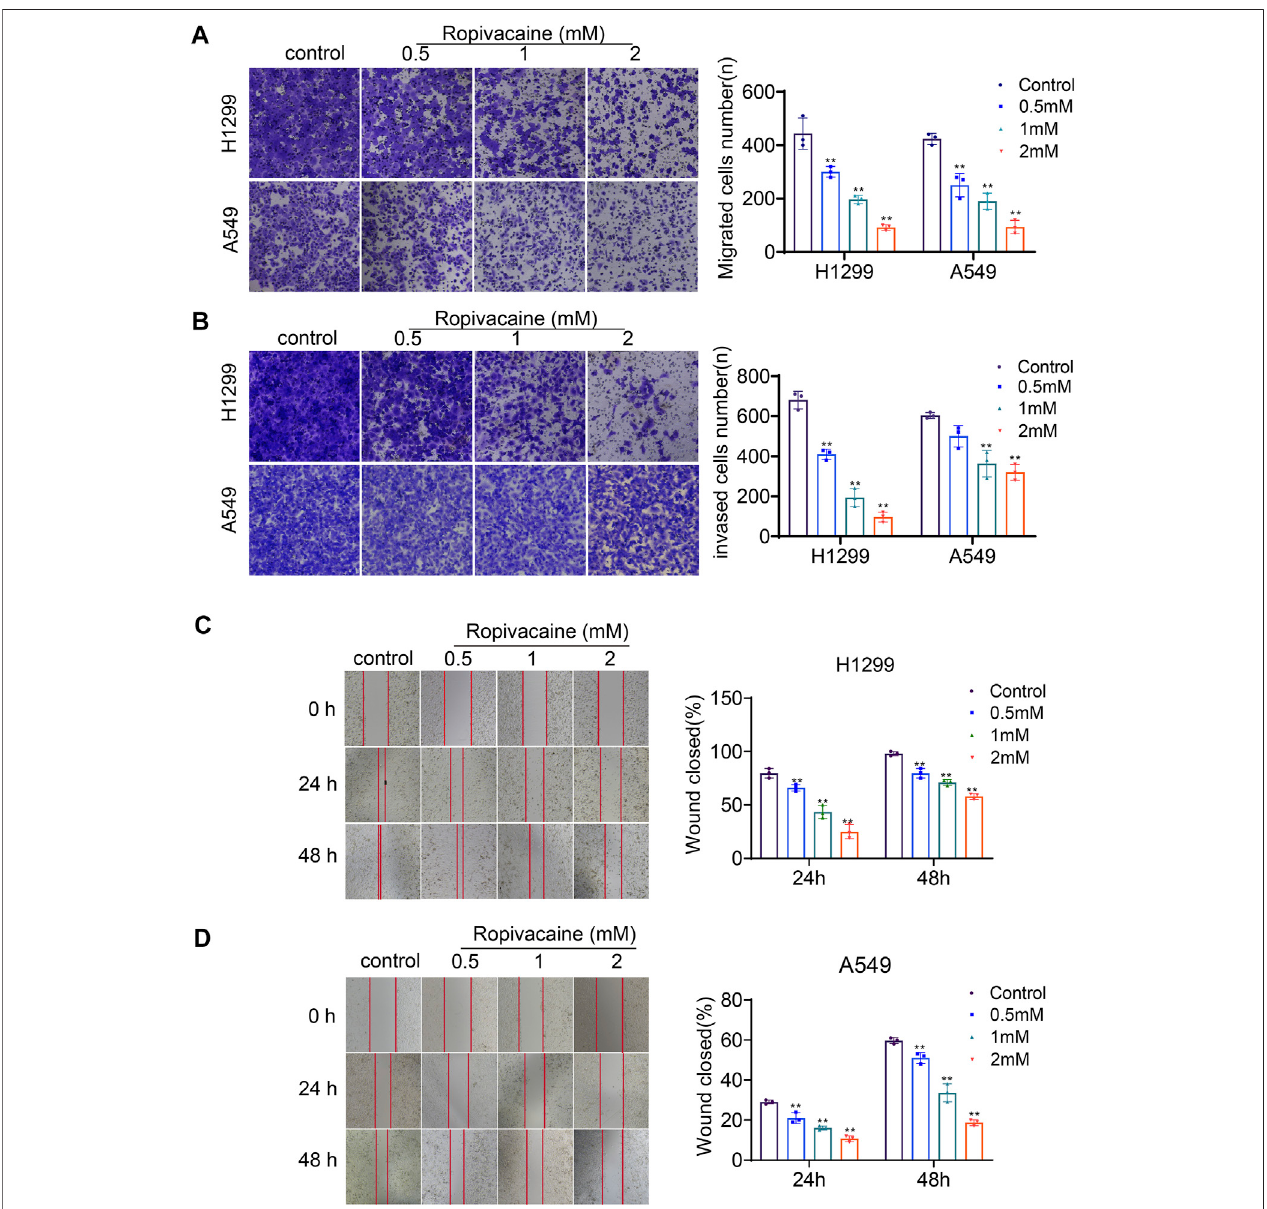
FIGURE 3 | Ropivacaine treatment induced migration and invasion changes. (A , B) Effects of ropivacaine treatment on migration and invasiveness of H1299 and A549 cells were investigated using transwell and Matrigel assays. The number of cells that migrated or invaded was counted in fi ve different fi elds. (C , D) Wound